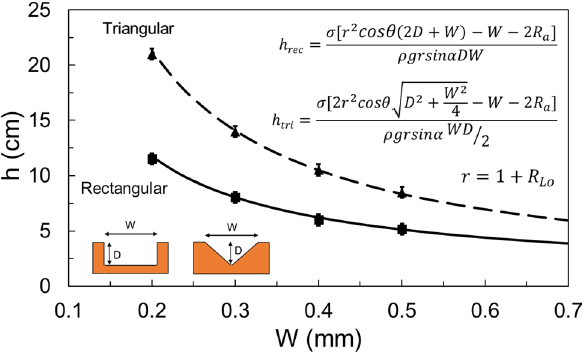
Figure 14. A comparison between capillary height in micro-grooves vs the micro-grooves’ width. Two cross- sections are considered, rectangular and triangular, and experimental results are compared against the present model, Eq. (11). Data for SLA1.03 sample.